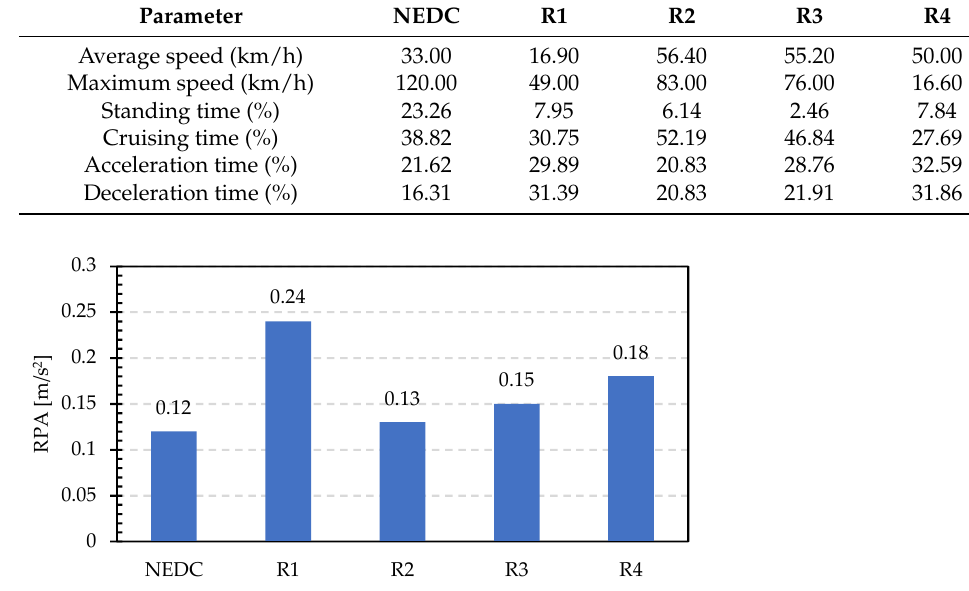
Figure 4. Velocity profiles of the four real driving routes obtained from one PEMS test. Table 4. Comparison of the kinematic characteristics in the speed profiles.